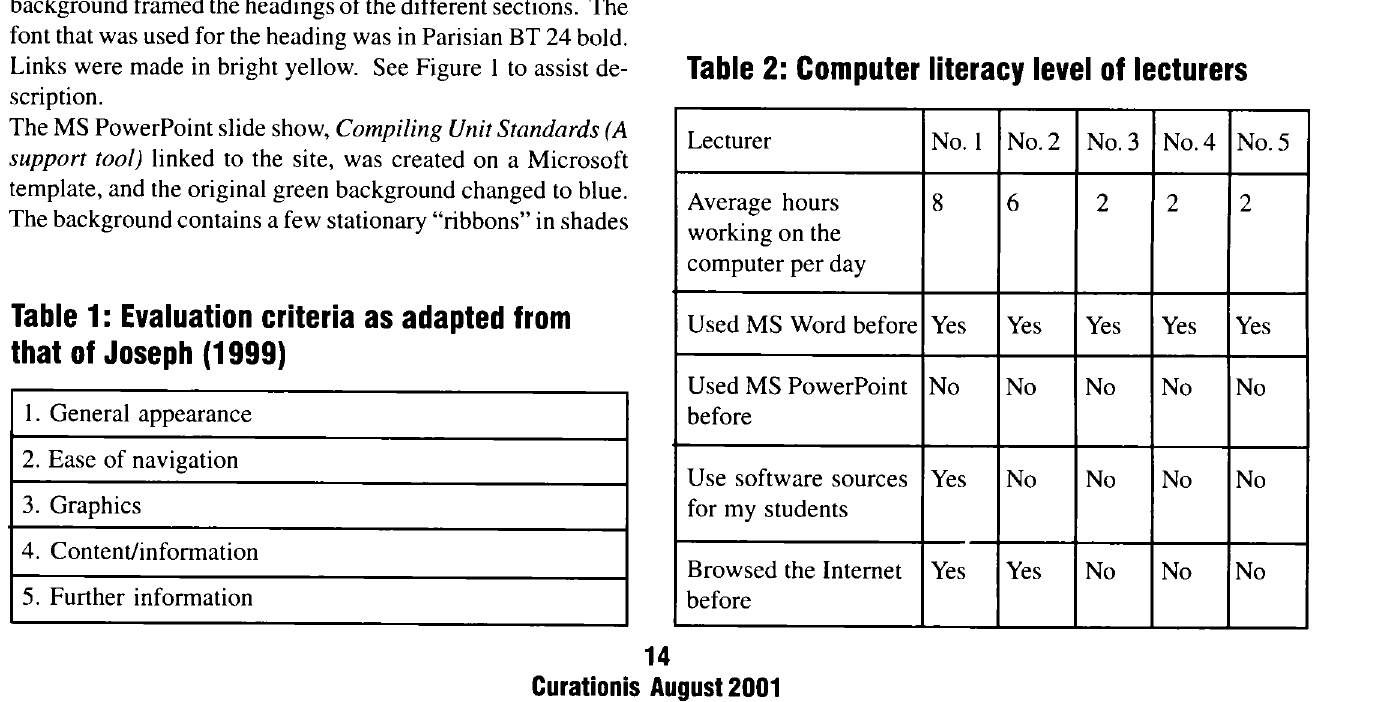
Table 2: Computer literacy level of lecturers